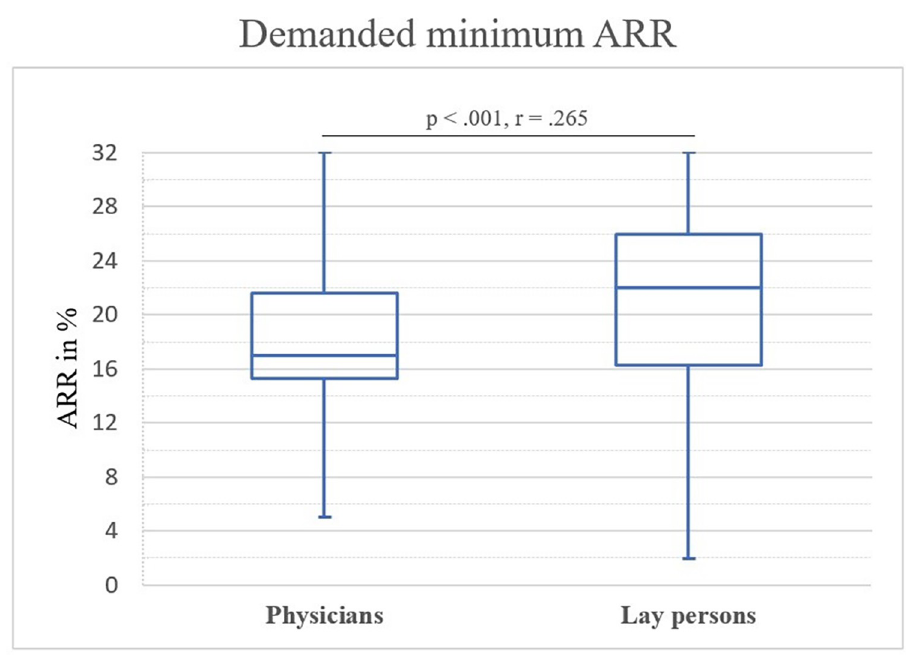
Fig 3. Box plot representation of demanded ARR of physicians and lay persons. Median, Q1 and Q3) are reported. Whiskers indicate minimum and maximum. Question: “What efficacy do you expect of the drug in this case? I expect the drug to reduce the patient’s/my risk from 32% to at least ...